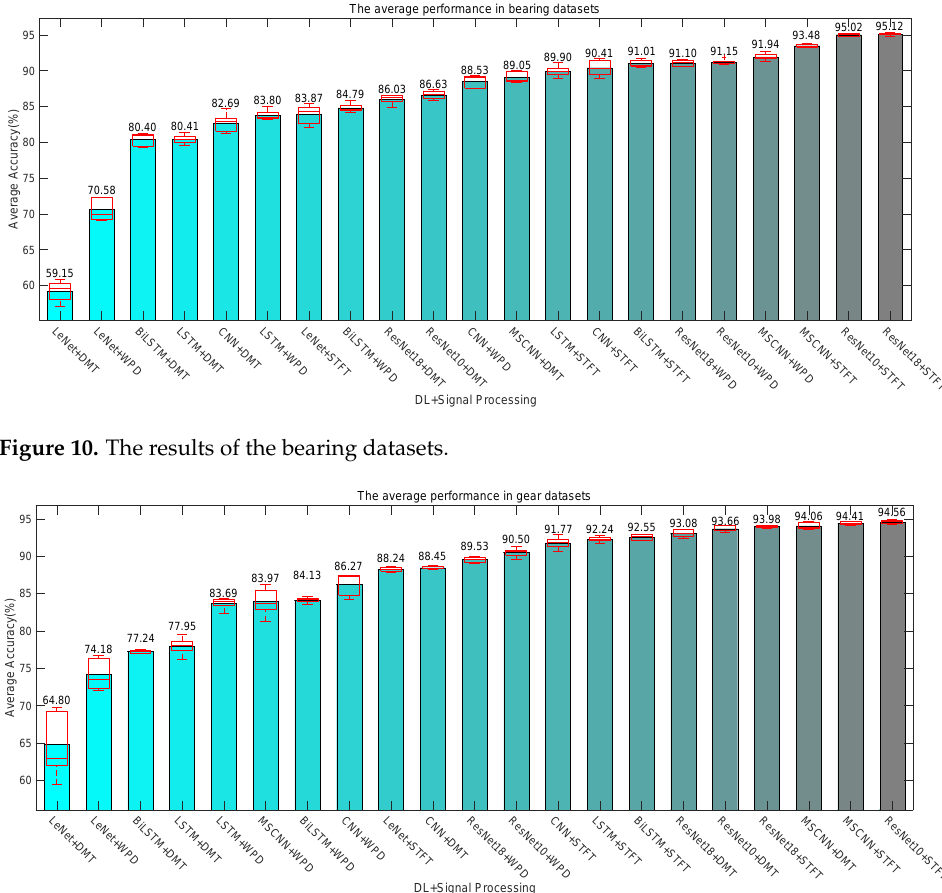
Figure 11. The results of the gear